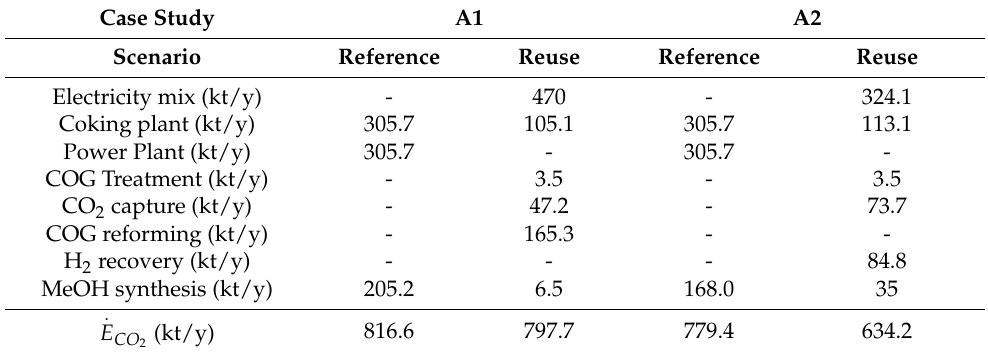
Table 10. Contributions to carbon dioxide emissions (ktonCO 2 /year) for both case studies A1 and A2. Case Study